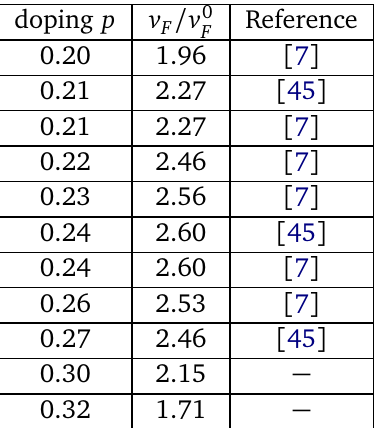
is taken F is the Fermi velocity F [ 46,50– N